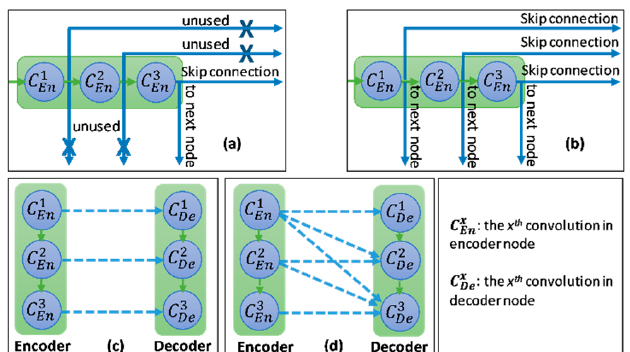
Figure 1. Illustration of the divergences between the connection of ( a ) tradition Unet and ( b ) the proposed model; the difference between ( c ) skip connection and ( d ) dense skip connection. The blue line denotes the output feature map of the convolution unit while the blue dashed arrow depicts the skip connection path; C(x,en): the xth convolution in encoder node; C(x,de): the xth convolution in decoder node.